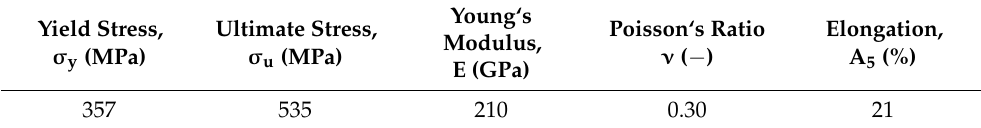
Table 2. Mechanical properties of the S355 steel.